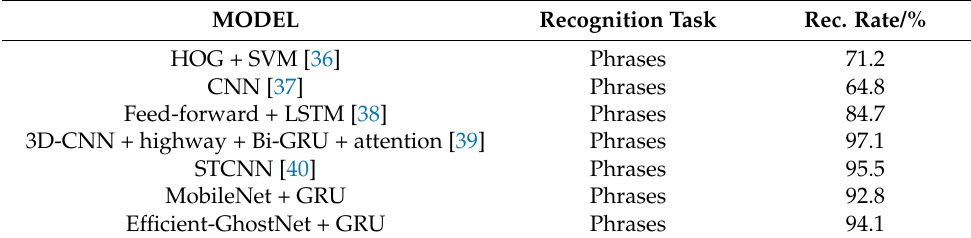
Table 3. Performance comparison of each model with the GRID dataset.